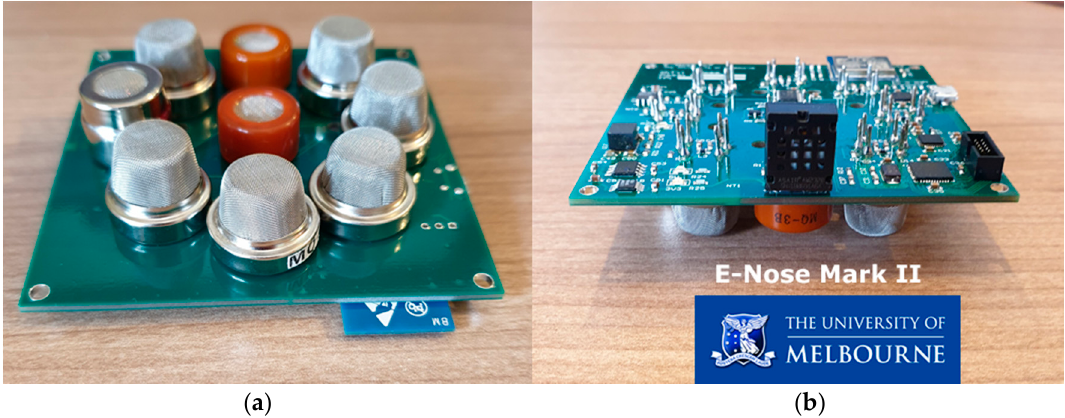
Figure 1. Electronic nose showing ( a ) the front side with the nine gas sensors attached to the printed circuit board (PCB) and the mini security digital (SD) card to store data, and ( b ) the back/side of the PCB. Table 1. Sensors integrated into the electronic nose.